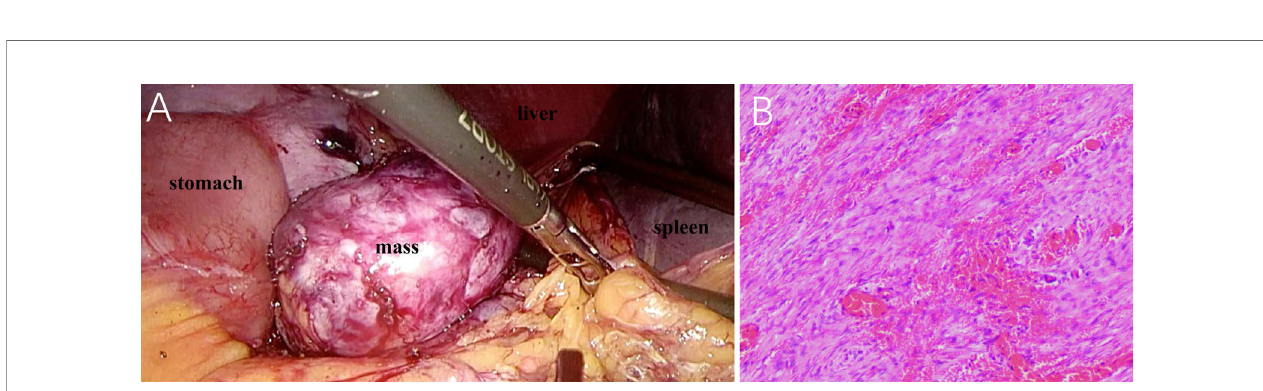
FIGURE 2 | The 18 F-FDG PET/CT images [ (A) : maximum intensity projection image, (B) : the transverse CT, (C) : PET, (D) : fusion] show minimally increased FDG uptake with SUVmax of 3.6 in the lesion